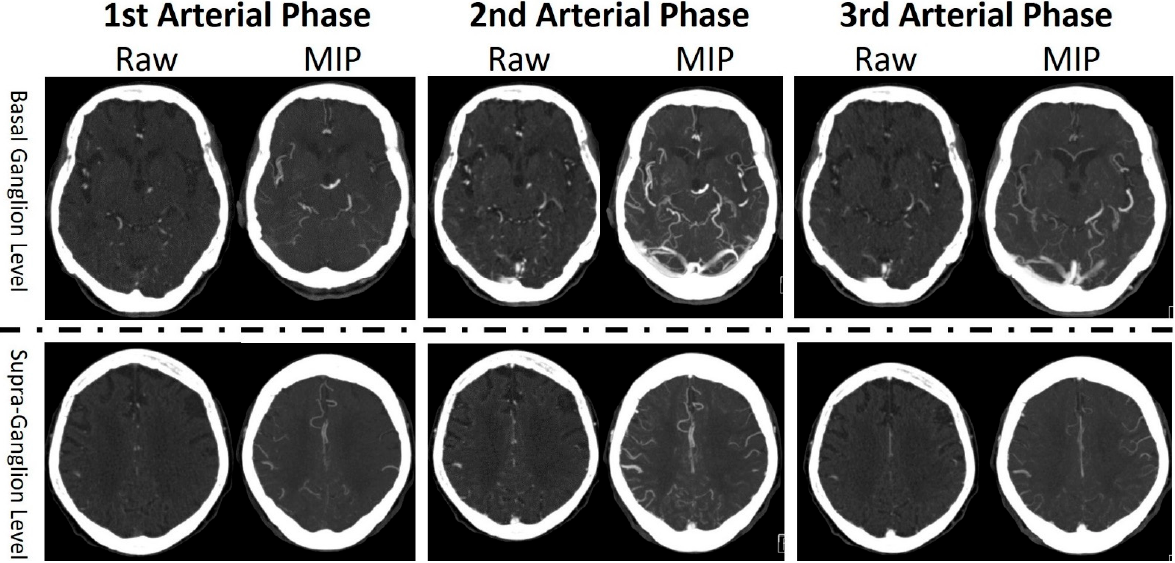
Figure 1. Demonstration of 12 images selected from each multiphase CTA